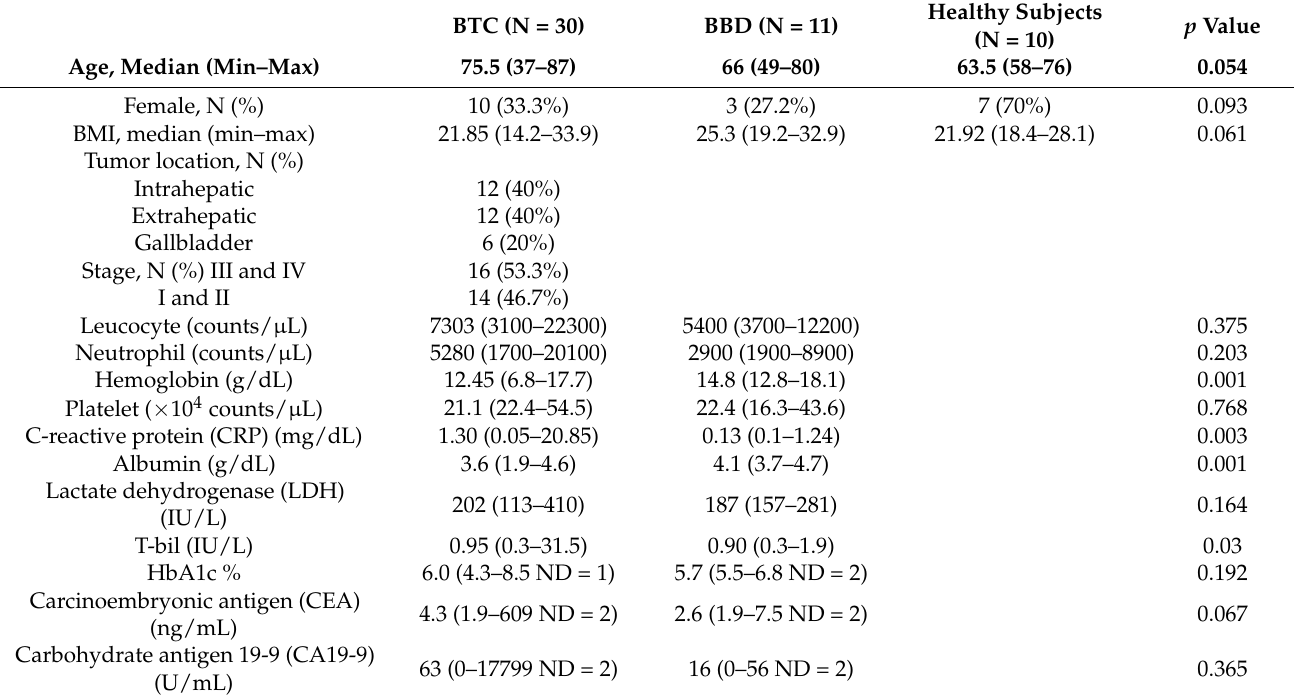
Table 1. Clinical and laboratory data of study